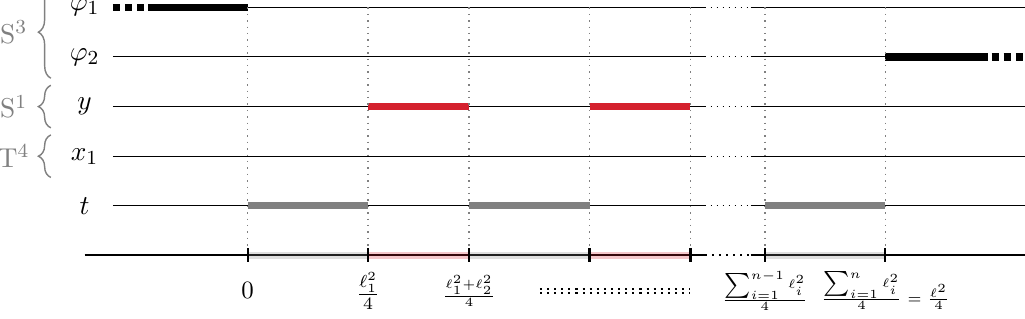
The solution corresponds to a non-extremal static BTZ black hole with a S 3 / Z black hole carries Q and Q D1 and D5 charges, and the S 3 × T 5 horizon is located at the 1 5 rod, r = 0 . The temperature can be derived from